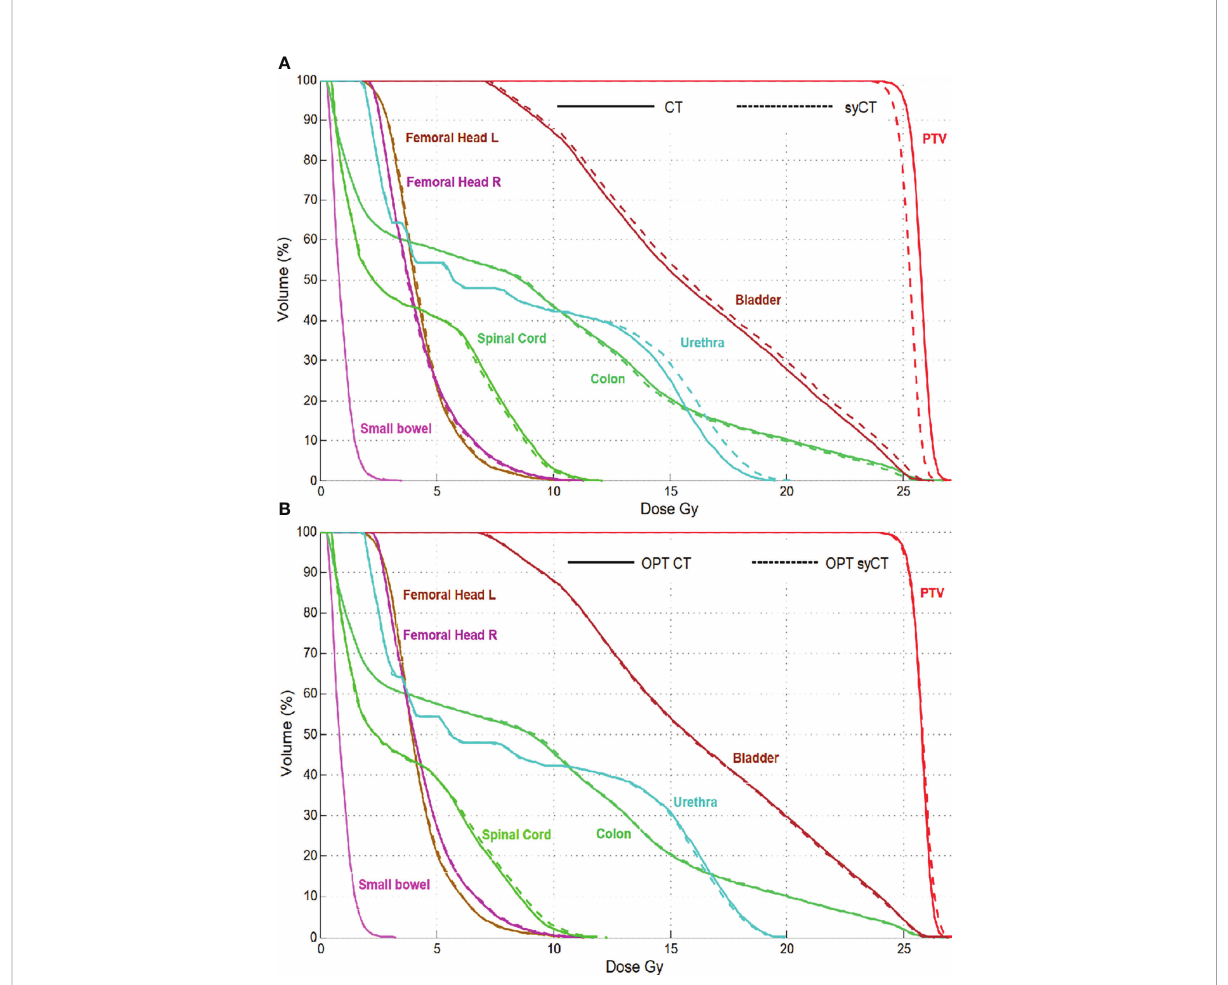
FIGURE 3 Rectum case 1: DVH comparison of the original CT plan and its corresponding syCT plan (A) and of the reworked CT reference plan with its corresponding syCT (B) .